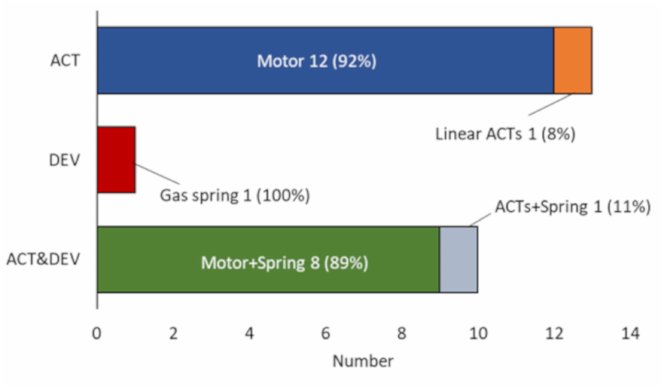
Figure 4. Summary of power unit classification in wearable